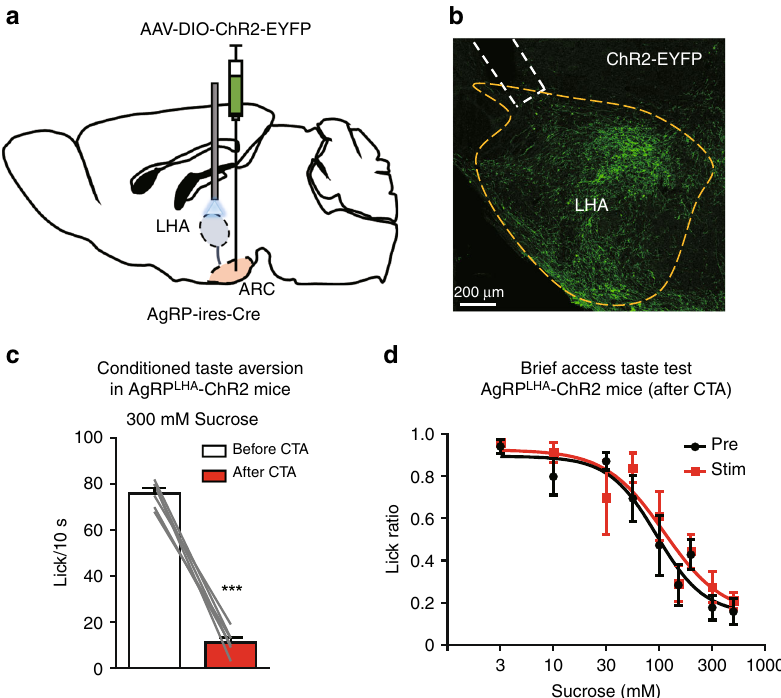
Fig. 3 LHA-projecting AgRP neurons do not affect sweet taste sensitivity after CTA. a Schematic image of the injection of AAV-DIO-ChR2-EYFP into the ARC with bilateral optic fi ber insertion above the LHA for photostimulation in the AgRP-ChR2-EYFP mouse. b Representative image showing ChR2-EYFP expression at axon terminals of AgRP neurons in the LHA and the approximate placement of an optic fi ber (dashed lines). c Licks for 300 mM sucrose in 10 s before and after CTA conditioning. n = 6, paired Student ’ s t test. d Brief access taste tests for sucrose solution in the presence or absence of optogenetic activation of LHA-projecting AgRP neurons after CTA conditioning. n = 6, F = 1.272, and P = 0.262, two-way ANOVA with Bonferroni post hoc test. All experiments were carried out with 10- to 16-week-old male mice. Data are given as means± SEM. *** P <